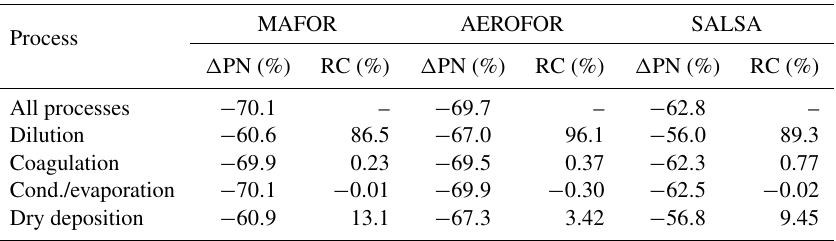
Table 8. Importance of dilution and aerosol processes in the Urban Case scenario: relative changes in total PN concentrations between points A and D ( (cid:49) PN) and relative contribution (RC) of dilution and aerosol processes. MAFOR AEROFOR SALSA Process (cid:49) PN (%) RC (%) (cid:49) PN (%) RC (%) (cid:49) PN (%) RC (%) All processes − 70 . 1 – − 69 . 7